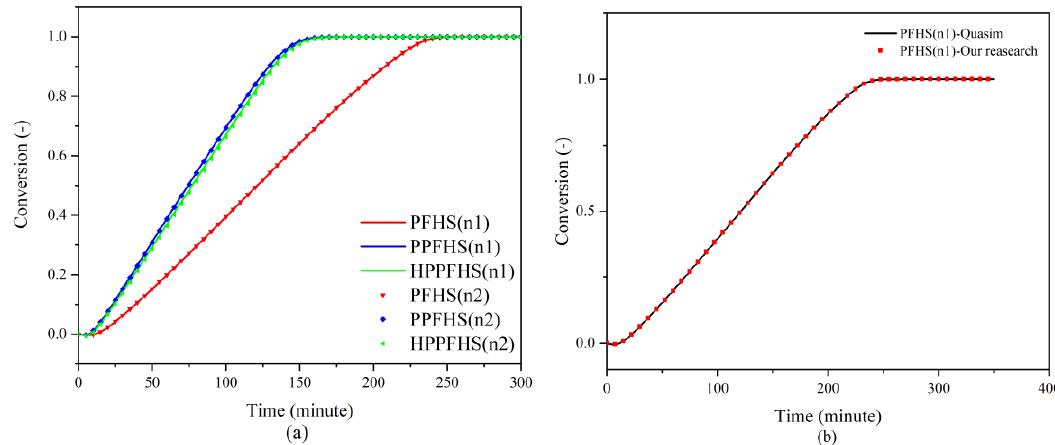
Figure 4. ( a ) Average conversion changes of the material over time during the dehydration by using PFHS (n1 & n2), PPFHS (n1 & n2) and HPPFHS (n1 & n2) reactors. ( b ) Average conversion changes over time by using PFHS (n1) model in this work and in Qasim’s respectively. (dehydration, ε = 0.5, u = 25 m/s).